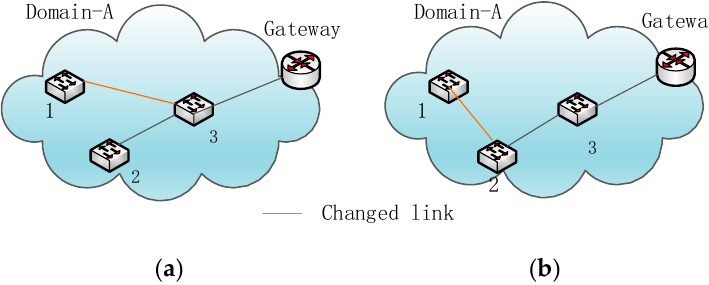
Figure 3. ( a ) The Domain-A topology before disaster; ( b ) the Domain-A topology after disaster.